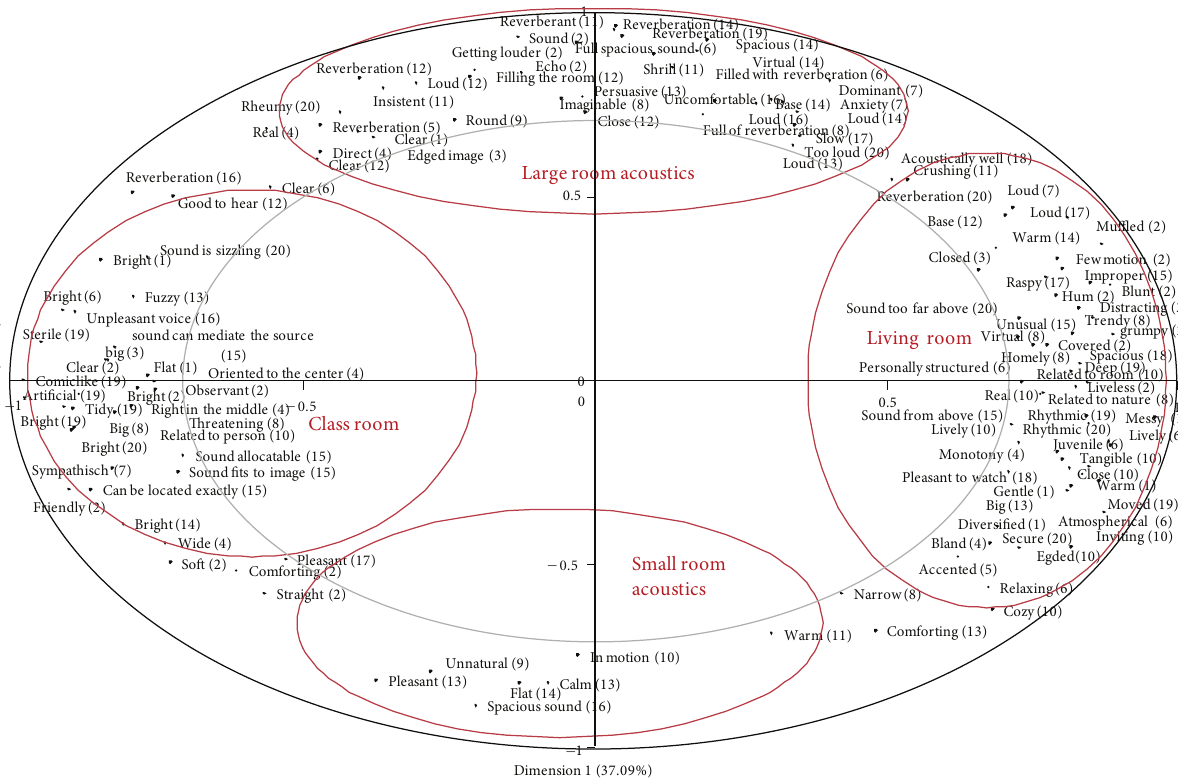
Figure 7: PCA correlation loadings with attributes in the space of PC1 and